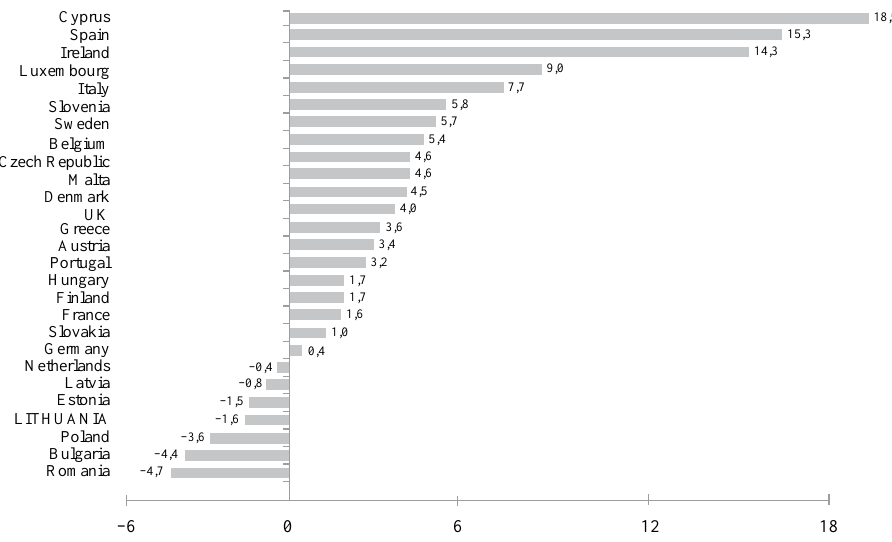
Romania 0 6 12 fig. 4. EU Member States crude net migration rate (2007, per thousand population, Eurostat provisional data)